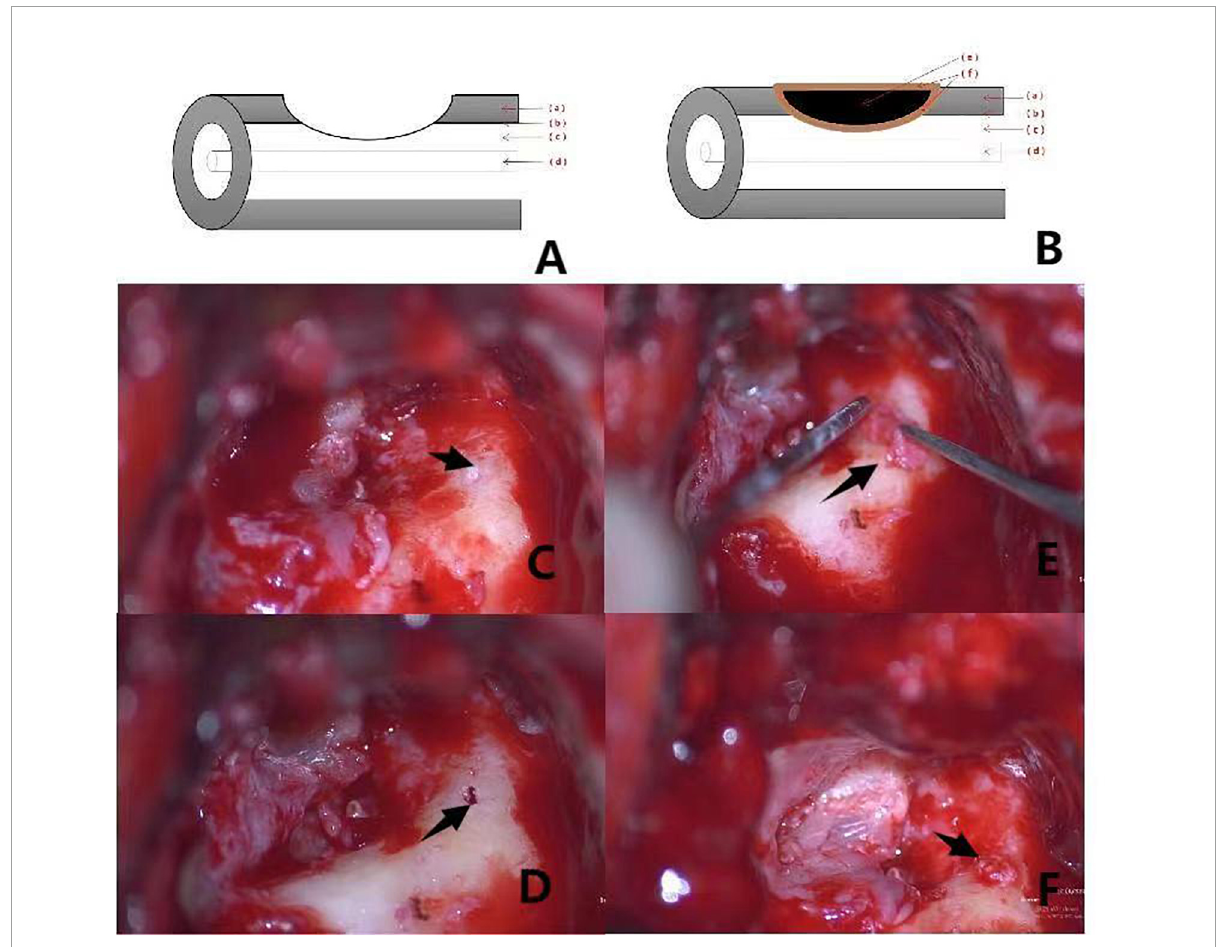
FIGURE2 (A,B) Shows the preoperative and postoperative pattern diagram of a patient with type II labyrinteric fistula. The red arrows (a–f) respectively, represent the bony labyrinth, endosteum, perilymphatic space, membranous labyrinth, bone meal, fascia. Pictures (C–F) are intraoperative of a patient with type II labyrinthine fistula. (C) : Labyrinthine type II fistula with superficial cholesteatoma epithelium showing deep invagination within the external semicircular canals (the black arrow). (D) : Destruction of the endosteum is visible after “under water” cleaning of the cholesteatoma epithelium on the surface of the fistula (the black arrow). (E) : Placement of clean bone meal inside the fascia with a “pie” filling of the external semicircular canal (the black arrow). (F) : Filling the posterior surface of the semicircular canal by application of fascia is observed (the black